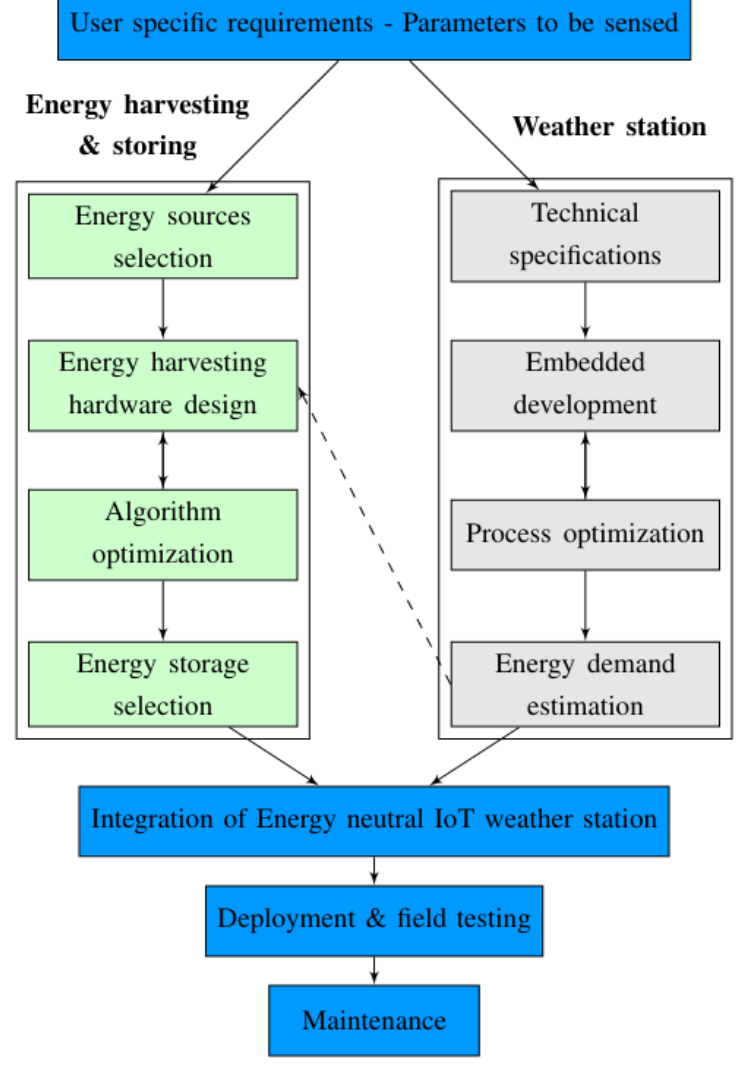
Figure 1. Development life cycle of IoT based weather station proposed in the previous work